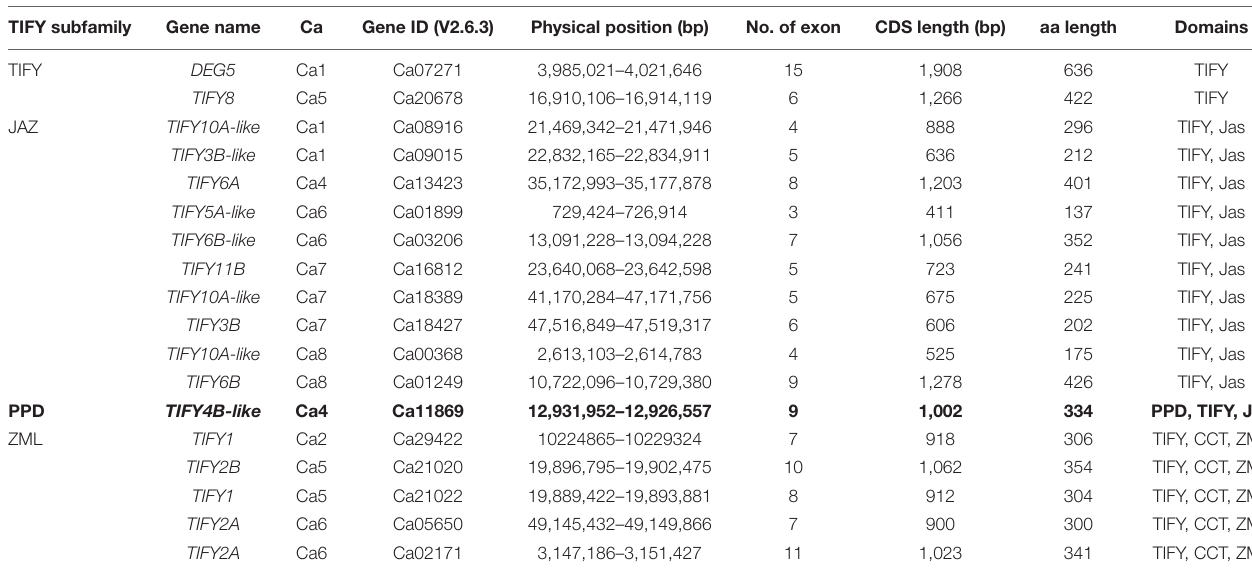
TABLE 1 | Structural and coding details of chickpea CaTIFY